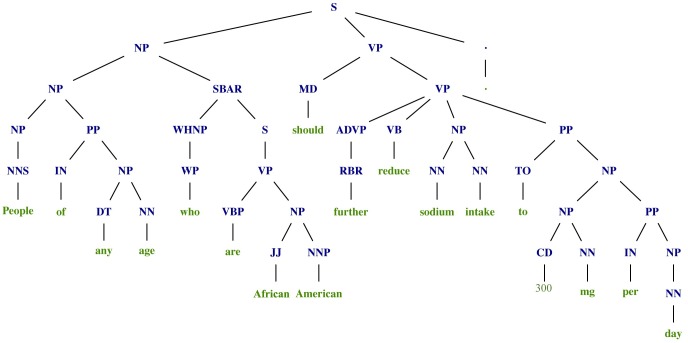
Parse tree of Φ1.